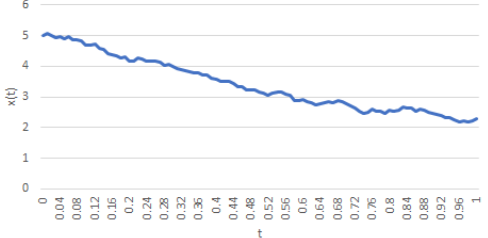
Figure 4. A realization of a trajectory of (7) with x 0 = 5, η = 1, σ ( x ) ≡ 0.5, u ( t ) = f λ ∗ ( t ) , T = 1, and N =